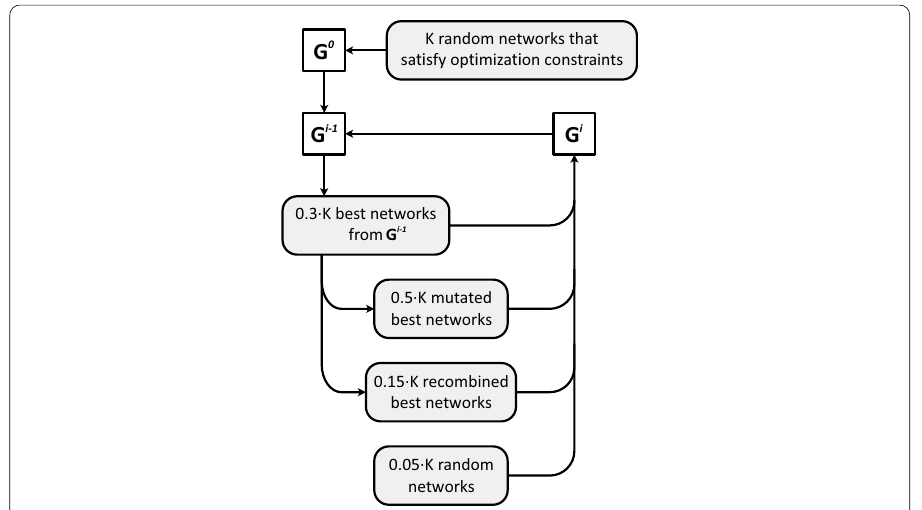
Fig. 3 Scheme of the optimization process. First, G 0 is created as random networks that satisfy the optimization constraints ( M , edge length, etc.). Then, to create the new generation, the algorithm picks the best networks from the previous generation and creates new networks by mutating and recombining the best networks. The new generation is finally created by combining the best networks from the previous generation, mutations and recombinations of randomly selected best networks, and purely random networks that satisfy the optimization constraints. Then, the procedure is applied to the new generation. The process is repeated for G N